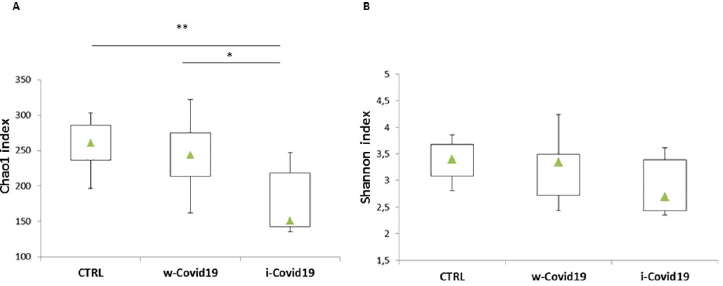
Fig 1. Box-plots of Chao1 index of species richness (A) and Shannon index of species diversity (B) in w-COVID19, i- COVID19 patients and CTRL. Triangles indicate the medians and Q1 and Q3 are